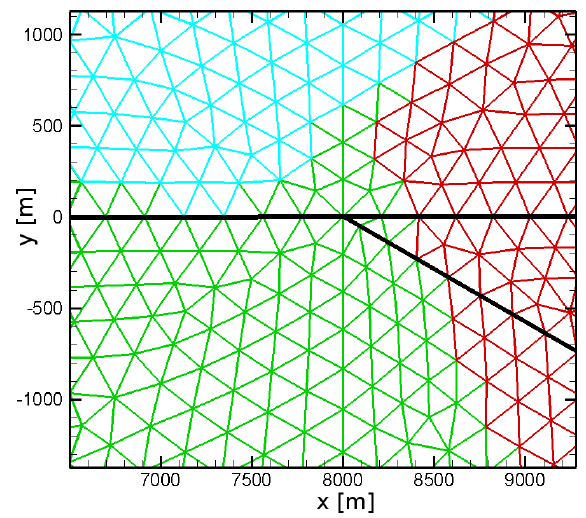
Fig. 8. Zoom view of the junction of TPV15 (2-D example) to illus- trate the parallelization concept and discretization